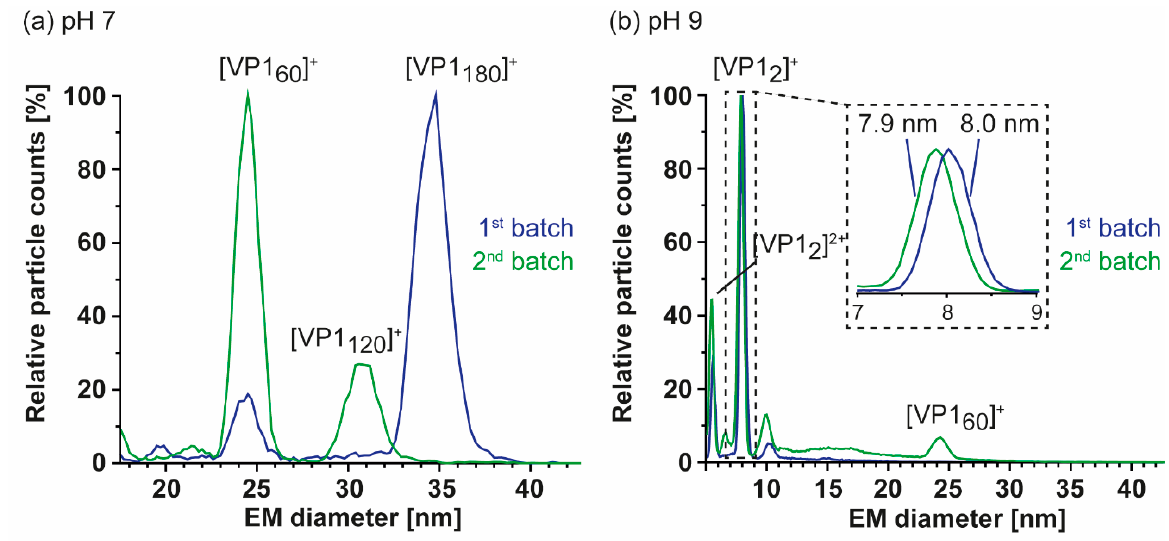
Figure 3. Comparison of two GI.1 West Chester VLP preparations using nano electrospray gas-phase electrophoretic mobility molecular analysis (nES GEMMA). Illustrative spectra are shown for both samples in 40 mM ammonium acetate at pH 7 ( a ) and pH 9 ( b ) at approximately 2–10 µ M VP1. Depicted are exemplary spectra for two batches in blue (1) and green (2). ( a ) Batch 1 shows a clear pattern with a main population of 34.37 ± 0.13 nm and less particle counts at 24.09 ± 0.27 nm, assigned to VP1 180-mer and VP1 60-mer. In batch 2, VP1 60-mer detected at 24.50 ± 0.12 nm is the most abundant species. Furthermore, a species at 30.71 ± 0.17 nm assigned to VP1 120-mer is present and VP1 180-mer is missing. ( b ) At pH 9, no VP1 complexes other than VP1 dimer were detected for batch 1. The second batch shows a small particle distribution at 24.18 ± 0.06, indicating higher stability of VP1 60-mers. A zoom at the electrophoretic mobility diameter (EMD) range depicts a minor difference in VP1 dimer size of 8.03 ± 0.01 nm for batch 1 and 7.89 ± 0.01 nm for batch 2. For both conditions, the shown EMD range was adjusted and the complete range including multiply charged species in the low EMD range are shown in Supplementary Figure S2.